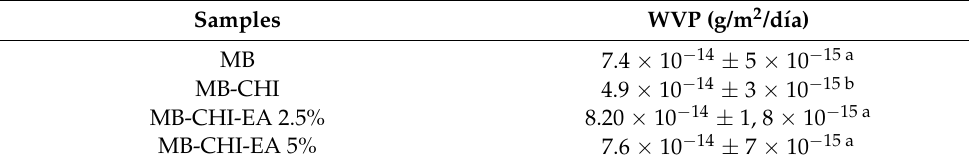
Table 2. Water-vapor permeability for the different samples